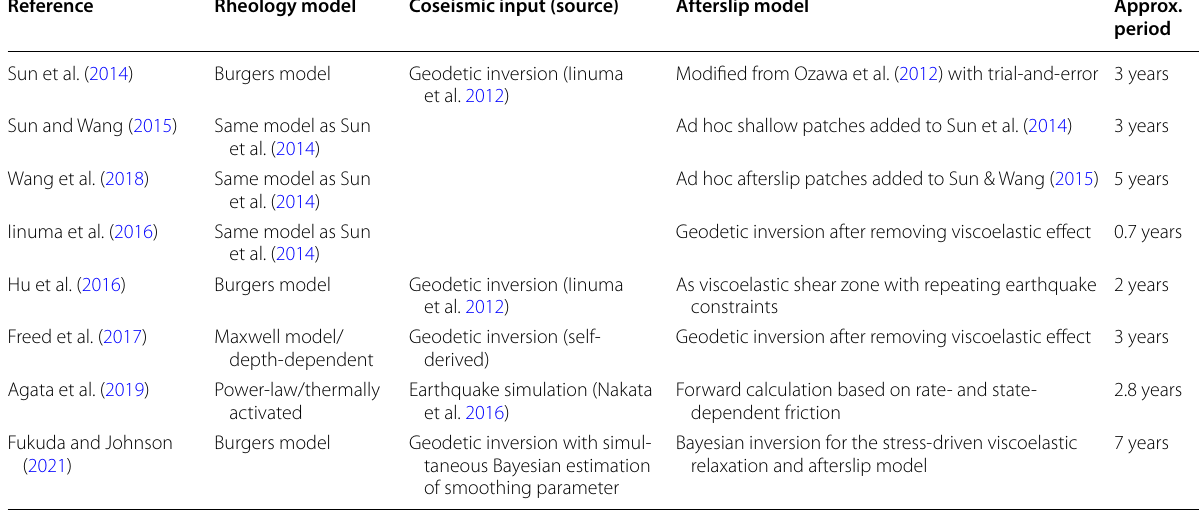
Models with (1) referencing the seafloor geodetic data, (2) incorporating the afterslip models, (3) modeling the subducting cold slab, and (4) calculating the viscoelastic deformation in an area wider than the latitude range of 37–39° N, are